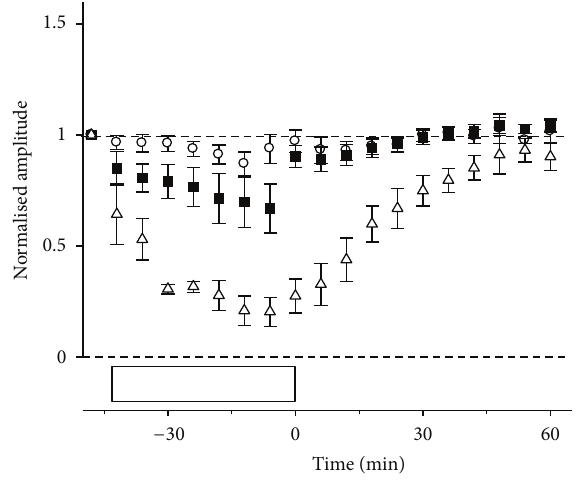
F 6: Relative amplitude of ERG components (mean SEM) during and aer IOP elevation to 50mmHg for 42min. (circles), (squares), and nSTR (triangles) amplitudes are compared. Horizontal reference lines indicate baseline and zero levels. Open boxes show the duration of IOP elevation. Reprinted 𝑃𝑃𝑃 𝑃𝑃2 from [57] with permission. e Association for Research in Vision and Ophthalmology remains the copyright